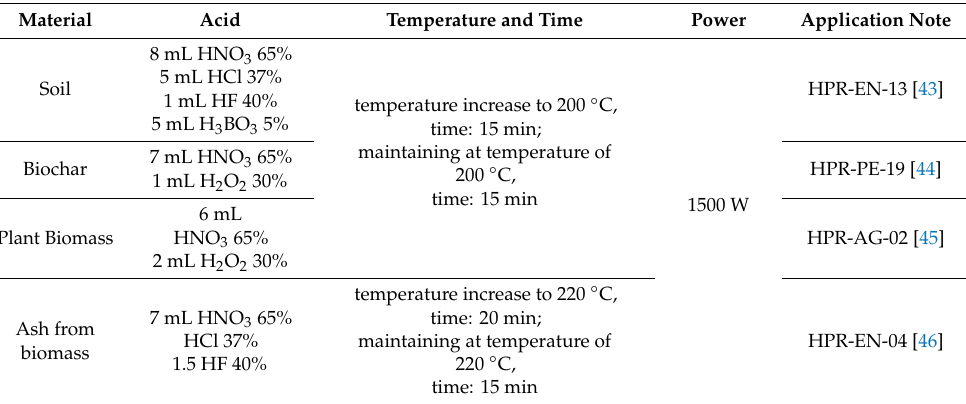
Table 2. Parameters of the mineralisation